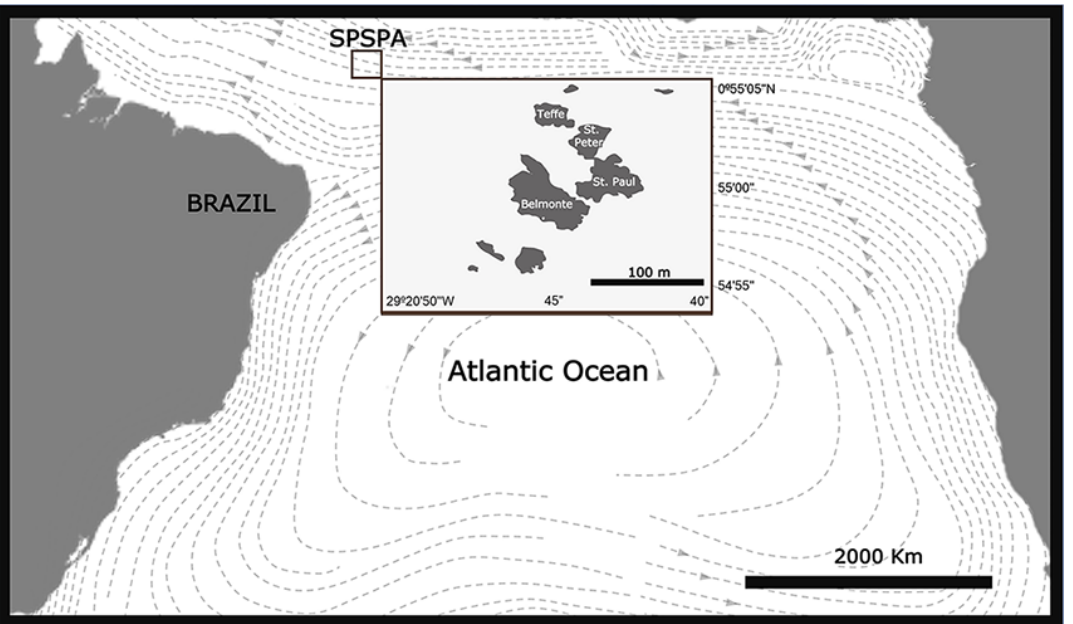
Figure 1 – Saint Peter and Saint Paul Archipelago (SPSPA) in a map showing its geographical location (white square) in the Mid-Atlantic